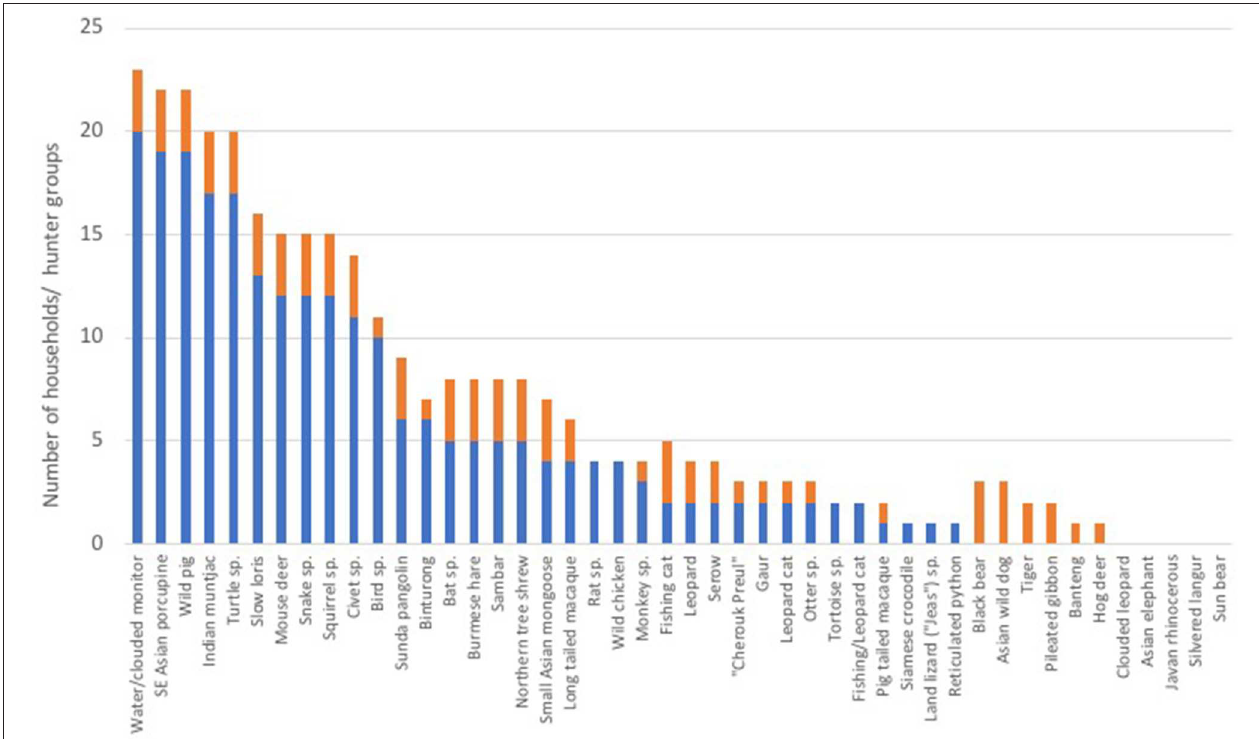
FIGURE 1 | The number of households and hunter groups [ n = 37 household (blue) and three hunter group (orange) interviews] that reported having hunted different species in the fields and forests surrounding the villages within the previous 5 years. “ Cherouk Preul ” was the name given to an unknown type of wild pig, reported by hunters to be different from the wild pig ( Sus scrofa ), which is known as “ Cherouk Prey ” in Khmer. Scientific nomenclature for each species is provided in Supplementary Material S4